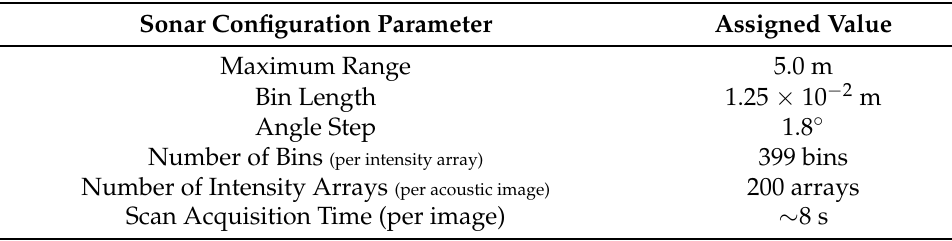
Table 4. Sonar parameter configuration for dataset